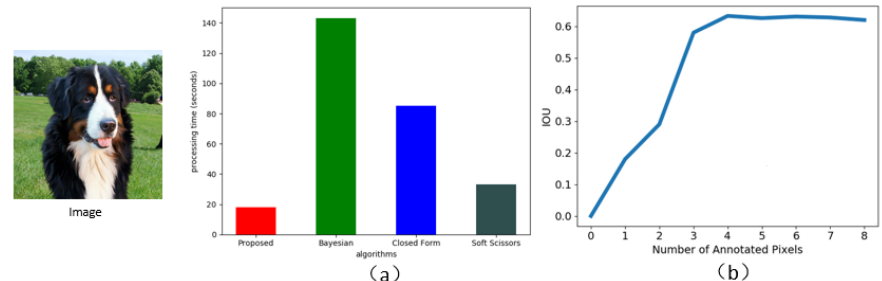
Figure 10. ( a ) The processing time of different methods. ( b ) The amount of interactive annotations in the image.